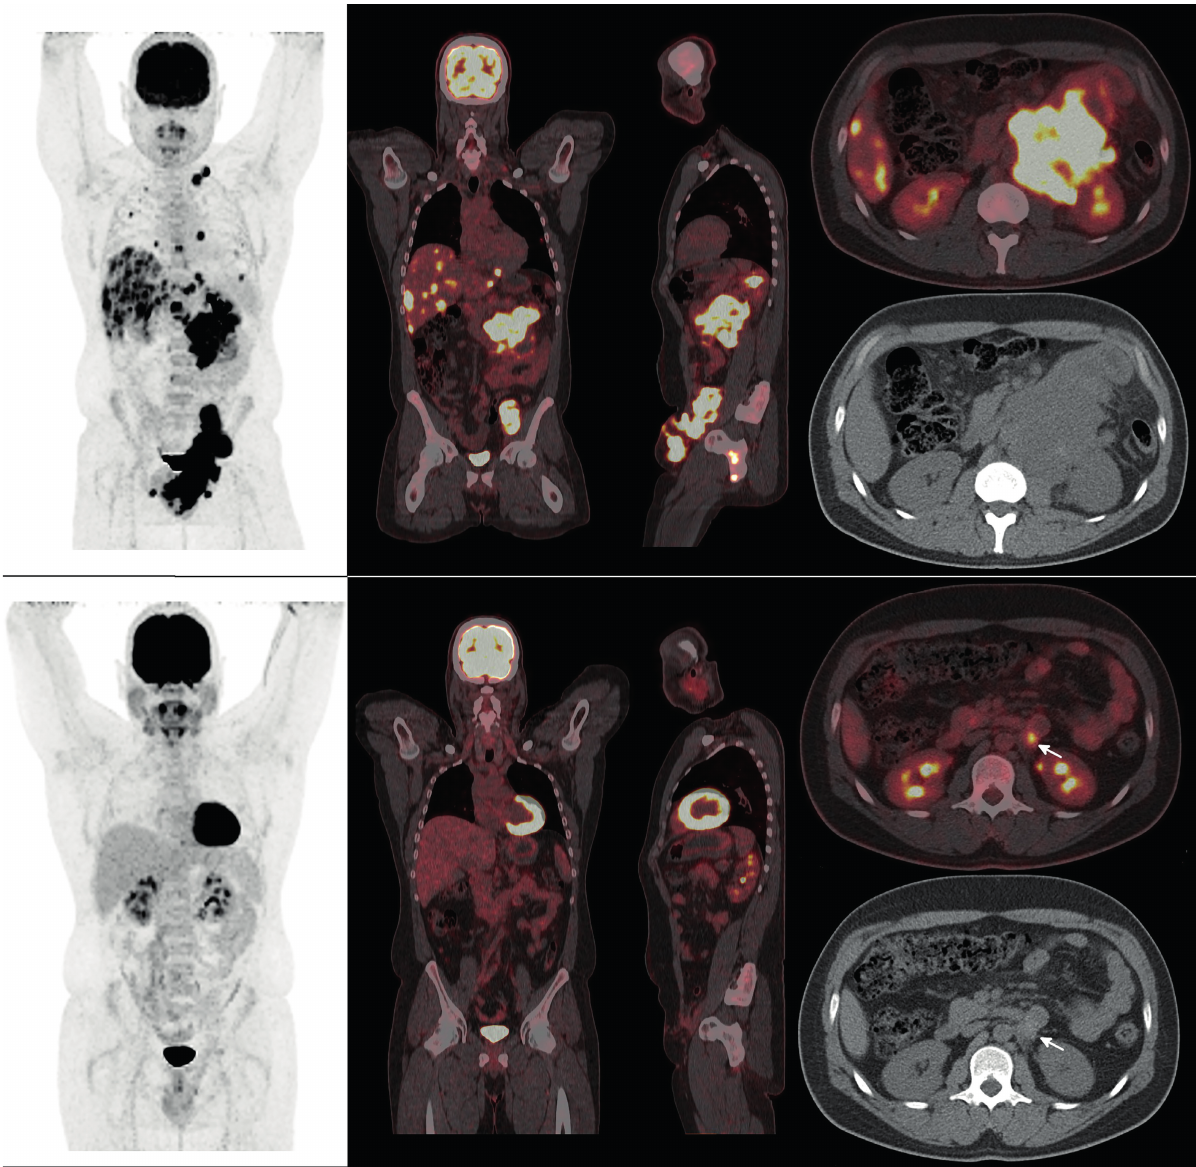
Figure 1 - Upper panel: Postoperative 18F-FDG PET/CT scan (MIP and fused coronal, sagittal and axial slices) revealed extensive scrotal-inguinal, pelvic, mesenteric, retroperitoneal, hepatic, pulmonary, supradiaphragmatic and skeletal dissemination, with high metabolic-rate (SUVmax: 22.7). Lower panel: Post-treatment 18F-FDG PET/CT (MIP and fused coronal, sagittal and axial slices) revealed an almost complete metabolic remission after four cycles, with the persistence of retroperitoneal minimal residual disease (arrows, SUVmax 6.1) that are candidates for surgical or radiotherapy